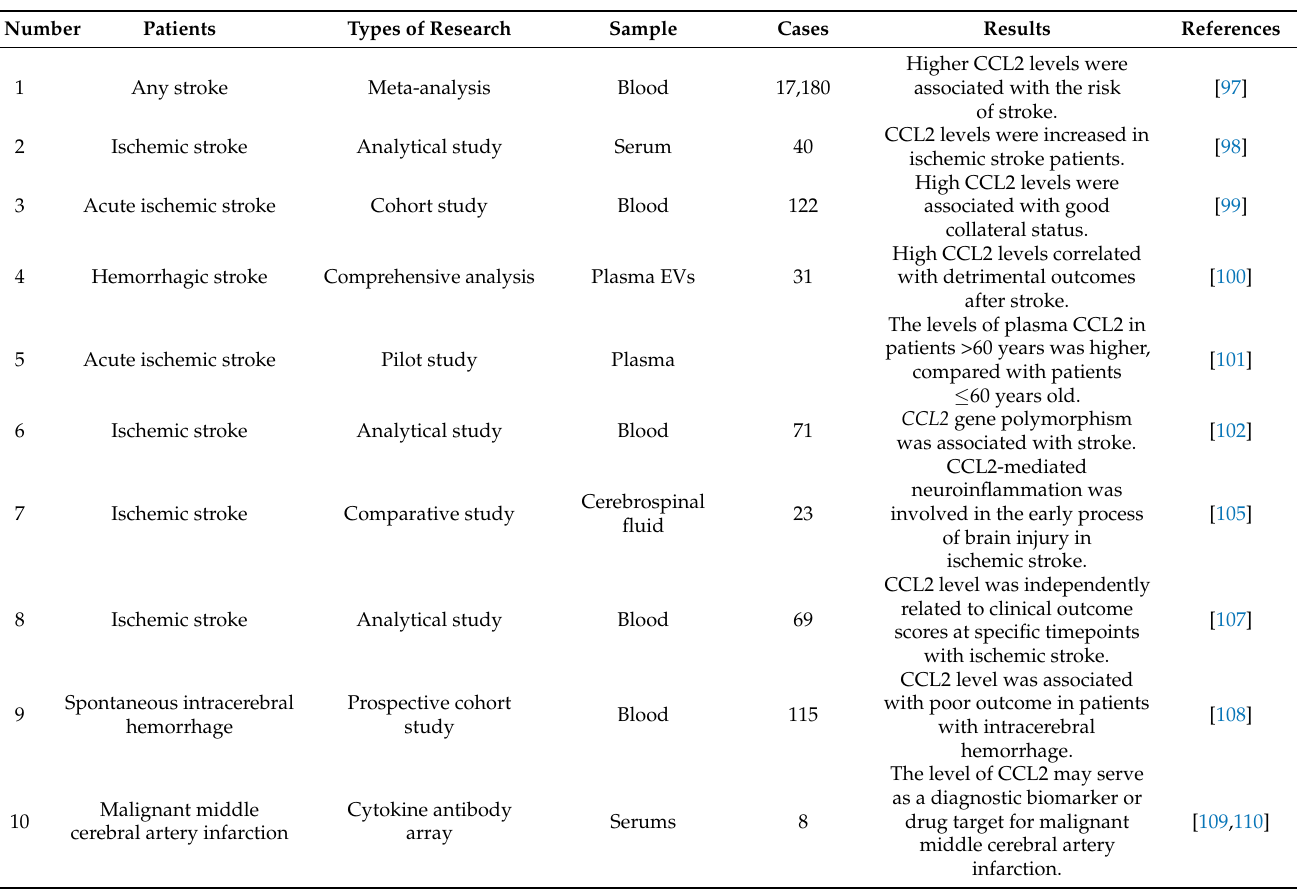
Table 2. The CCL2/CCR2 signaling pathway and stroke